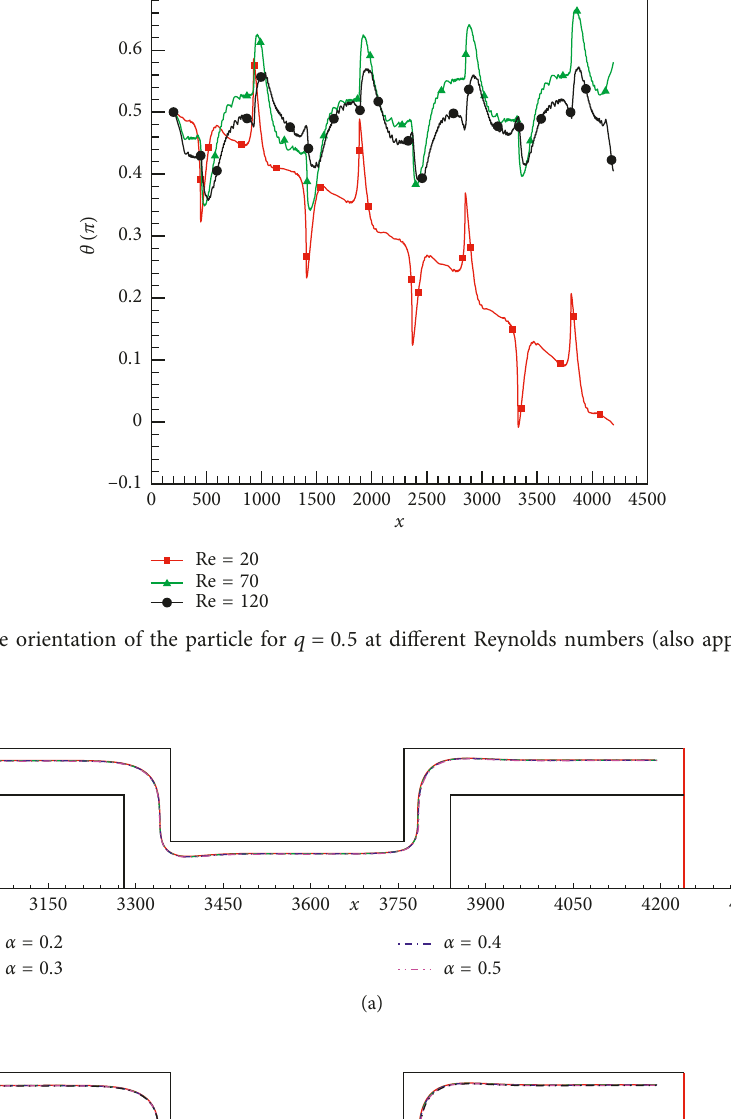
1: (a) α 0.2–0.5 and (b) α (cid:31) <